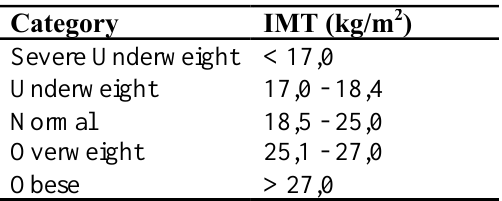
Table 7. GOLD Classifications of Spirometry